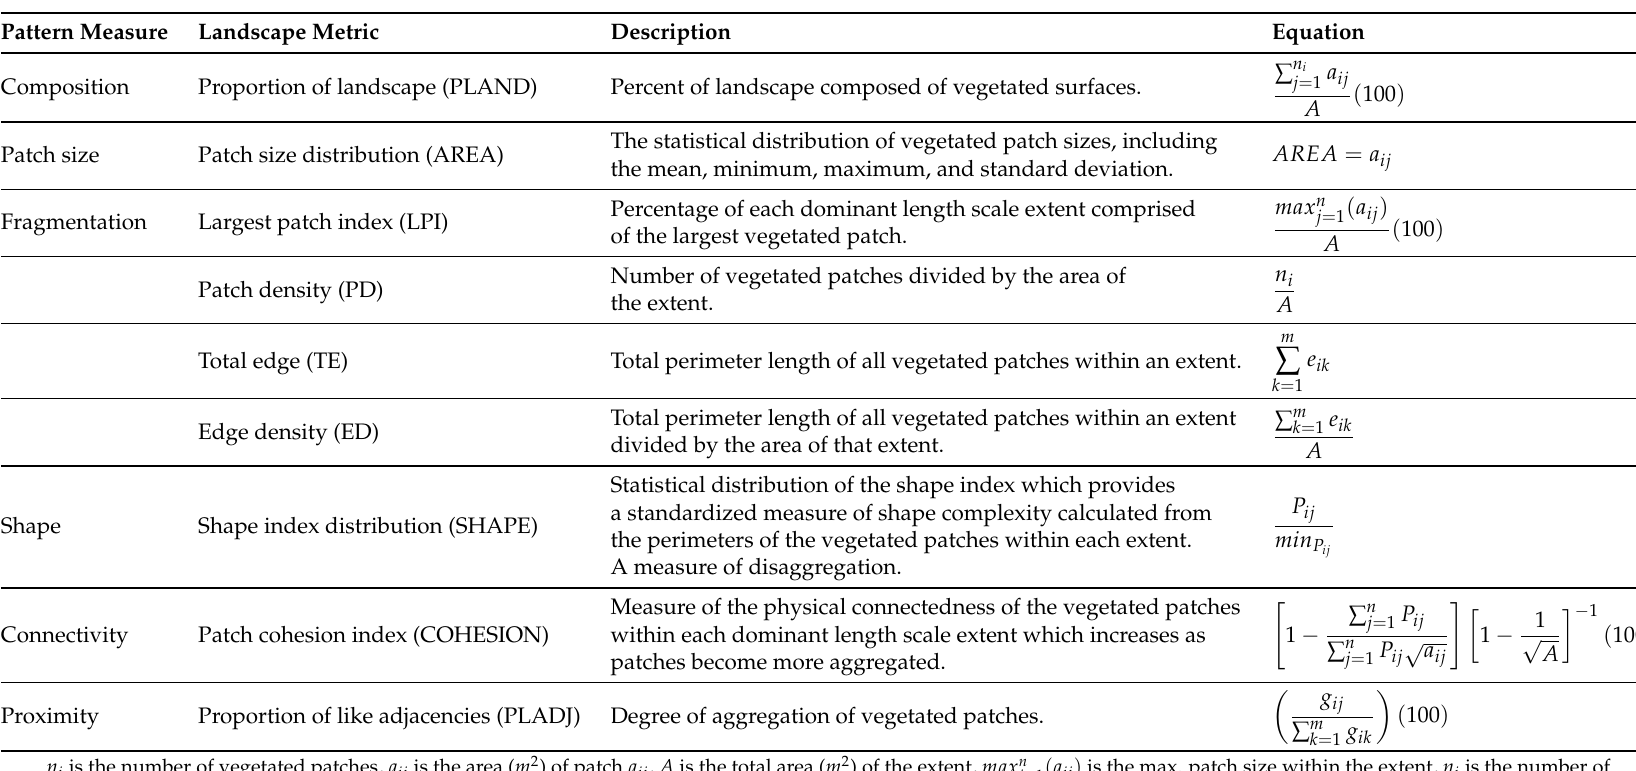
Table 2. Landscape metrics calculated to quantify landscape pattern. Composition is quantified by the proportion of landscape while configuration is quantified by the patch size, fragmentation, shape, connectivity, and proximity metrics. For a more in-depth explanation of landscape metrics see McGarigal